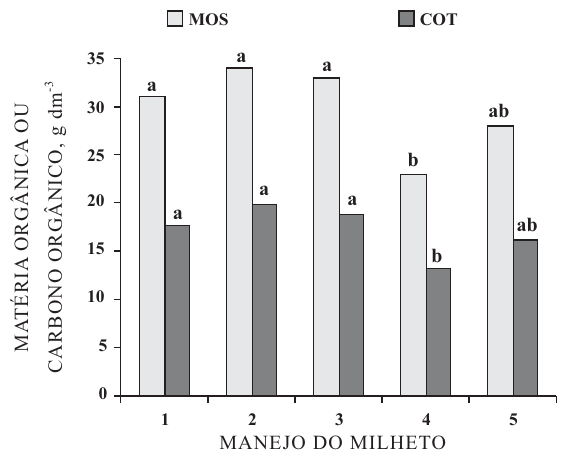
Figura 3. Teor de matéria orgânica do solo (MOS) ou carbono orgânico (COT) para os sistemas de manejo na época de semeadura E na camada 1 de 0–0,05 m (letras iguais não diferem entre si pelo teste LSD a 5 %). Manejo 1: ceifa a cada florescimento e retirada da fitomassa; Manejo 2: ceifa a cada florescimento e permanência da fitomassa; Manejo 3: ceifa apenas no primeiro florescimento e retirada da fitomassa; Manejo 4: ceifa apenas no primeiro florescimento e permanência da fitomassa; Manejo 5: livre crescimento, sem ceifar.